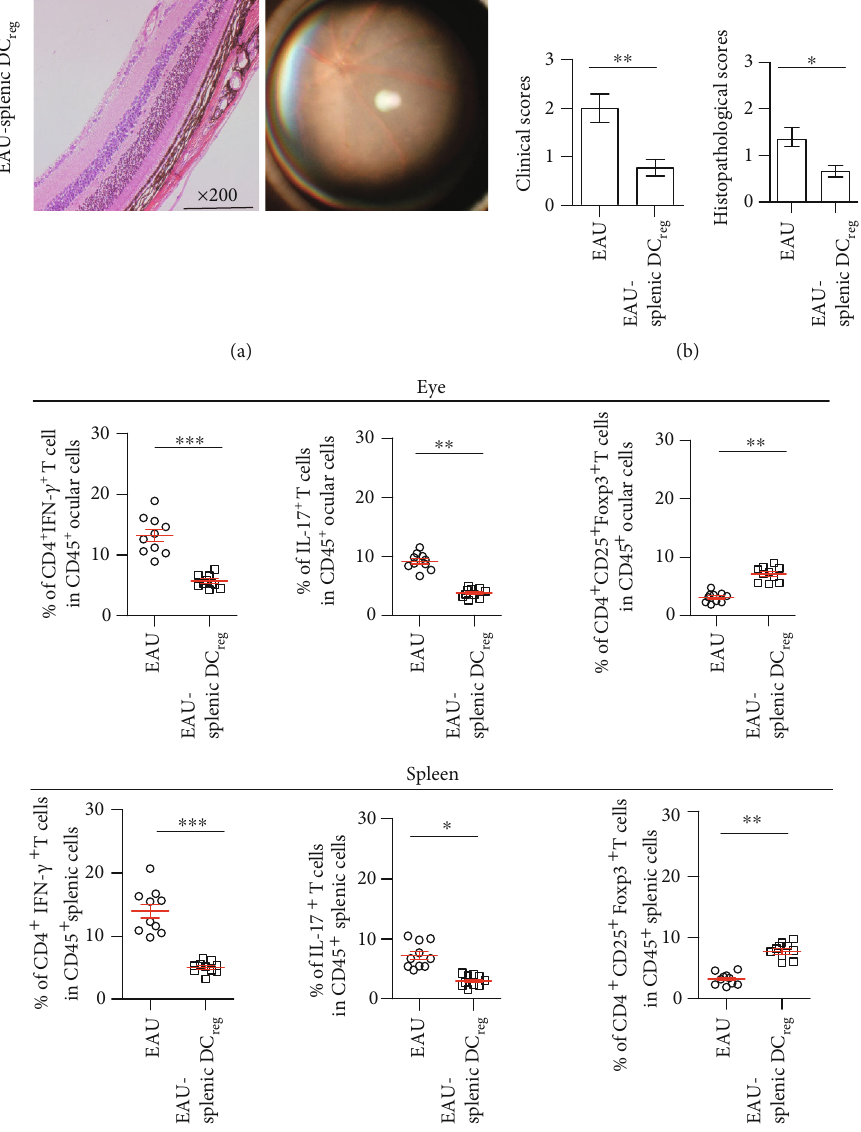
cells were isolated from the spleen of EAU and were reg